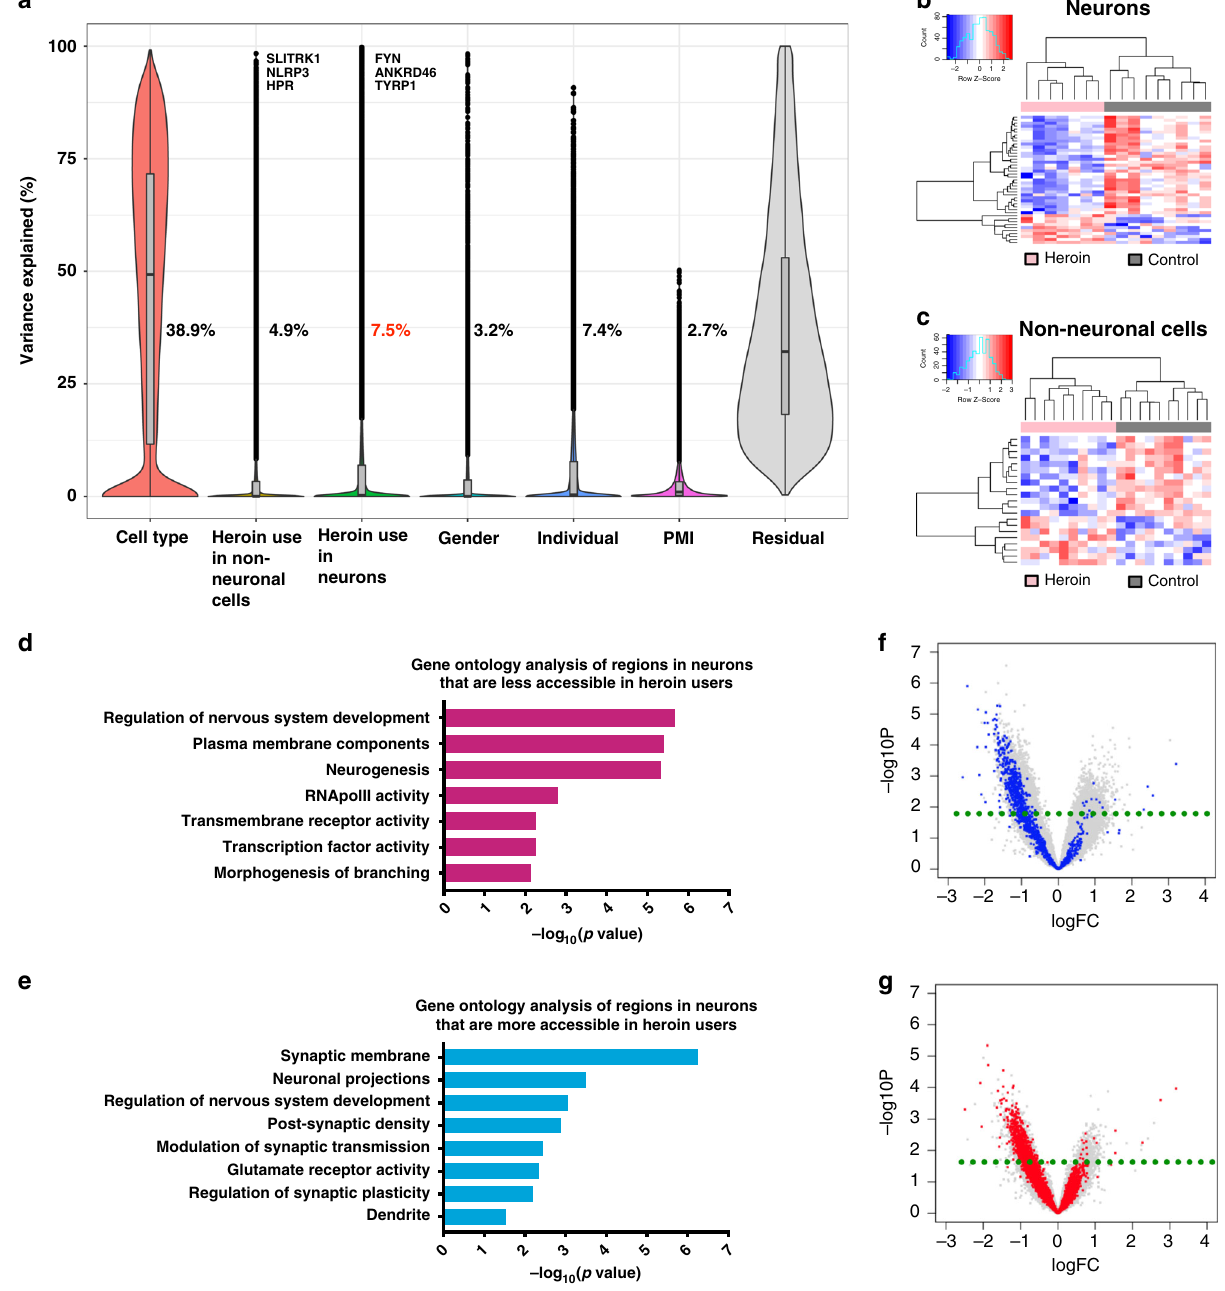
Fig. 2 Genome-wide changes of chromatin state in the post-mortem striatum. a Factors contributing to ATAC-seq signal variability. Violin plots showing the percentage of ATAC-seq signal variance explained by cell type (neuronal or non-neuronal), diagnosis (heroin vs. control; shown separately in neuron and non-neuronal cells), gender, individual variability, post-mortem interval, and residual factors. Top genes are indicated next to the plots. Within neurons, heroin-use group (heroin vs. control) was the primary source of variability. In this cell population, a peak close to the FYN gene ranked fi rst as the signal whose variance was most in fl uenced by drug group. PMI: post-mortem interval. Boxplots indicate median, 25th and 75 quantiles. The whiskers are de fi nted as 1.5× inter-quartile range (IQR). b , c Heat maps of differentially accessible regions in neuronal ( b ) and non-neuronal ( c ) cell populations revealed marked quantitative group differences. d Enriched gene ontology categories for neuronal ATAC-seq peaks that are less accessible in heroin users (minimum hypergeometric test). e Enriched gene ontology categories for neuronal ATAC-seq peaks that are more accessible in heroin users include terms related to synaptic function and membrane receptor activity (minimum hypergeometric test). f , g Volcano plots showing differentially accessible regions in heroin users compared to controls in neuronal ( f ) and non-neuronal ( g ) cell populations. Signi fi cant non-neuronal peaks are marked in blue on the neuronal plot ( f ) and signi fi cant neuronal peaks are marked in red on the non-neuronal plot ( g ). More regions were signi fi cantly affected by heroin in neurons, whereas regions affected in glia were mostly shared between the two cell populations. PMI post-mortem